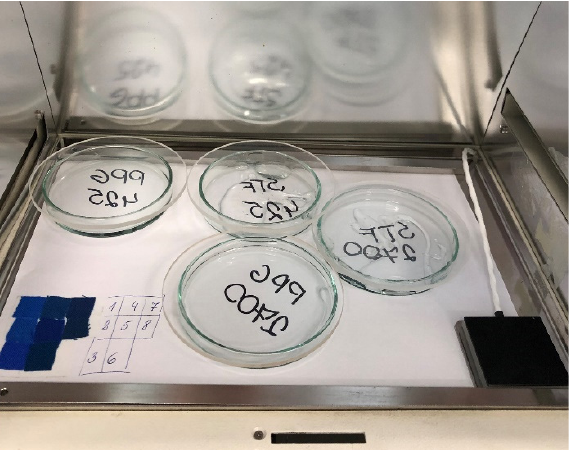
Figure 2. PPG and STF samples together with Blue Wool Scale prepared for aging.